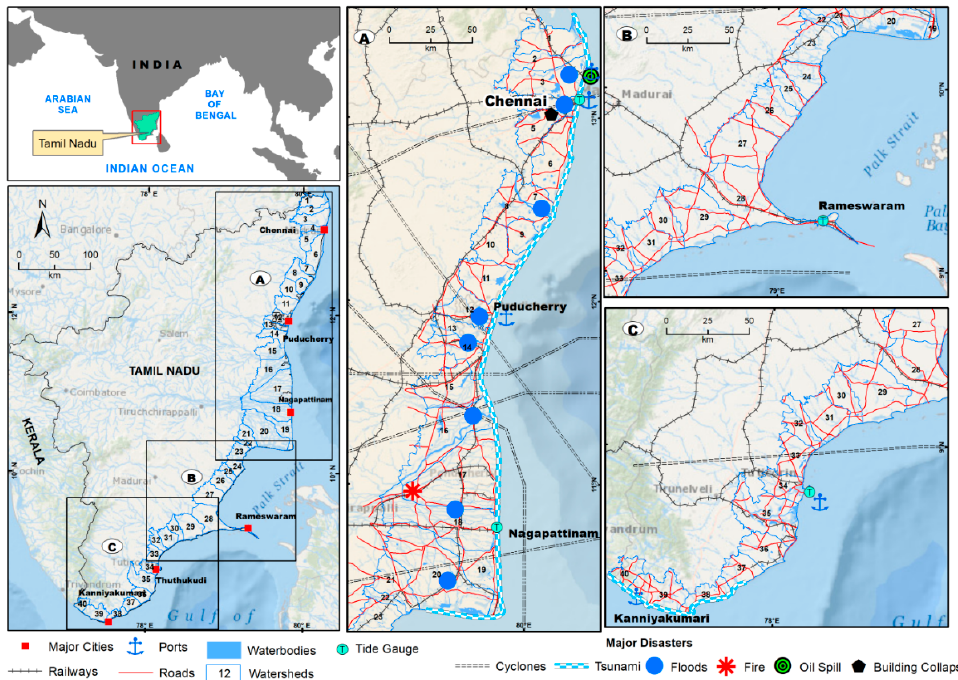
Figure 1. Location of the study area with micro-watersheds and major disaster events. The inset figures ( A – C ) represent the northern, central, and southern coastal plains of Tamil Nadu, respectively